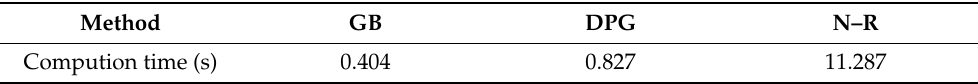
Table 2. Computation efficiency comparison.